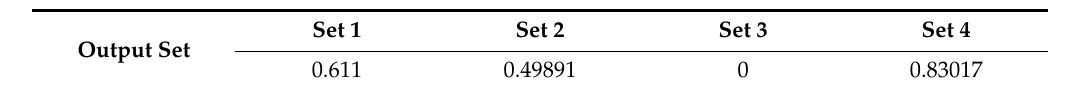
Table 4. Output Set of RNN.